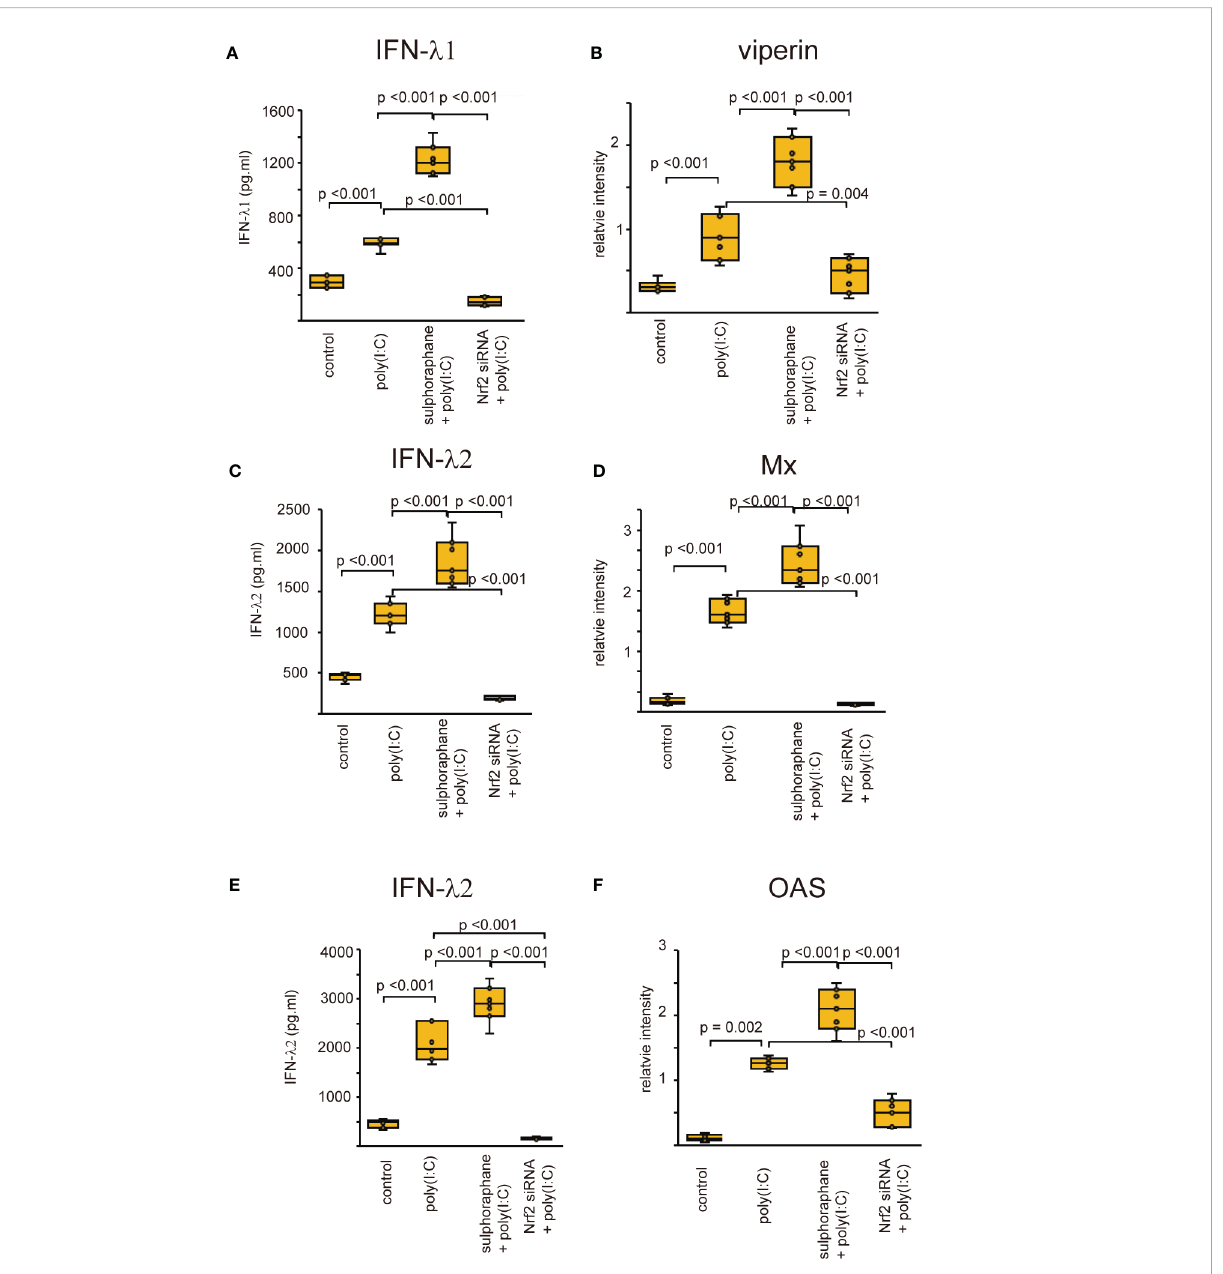
FIGURE 8 The concentration of IFN- b (A) , IFN- l 1 (C) , and IFN- l 2 (E) in basal media of cultured cells and the expression levels of viperin (B) Mx (D) and OAS (F) in cultured cells transfected with Nrf2 siRNA and pretreated with sulforaphane and then, followed by poly (I:C) treatment which were evaluated with ELISA (A, C, E) and western blot (B, D, F) . Data are mean ± SEM from 7 different epithelial donors. Control indicates non-treated normal epithelial cells. Poly (I: C) indicates epithelial cells treated with Poly (I: C). Sulforaphane + Poly (I: C) indicates the epithelial cells pretreated with sulforaphane at 5 uM followed by Poly (I: C) treatment. Nrf2siRNA + Poly (I:C) indicates the cells transfected with Nrf2 siRNA treated with Poly (I: